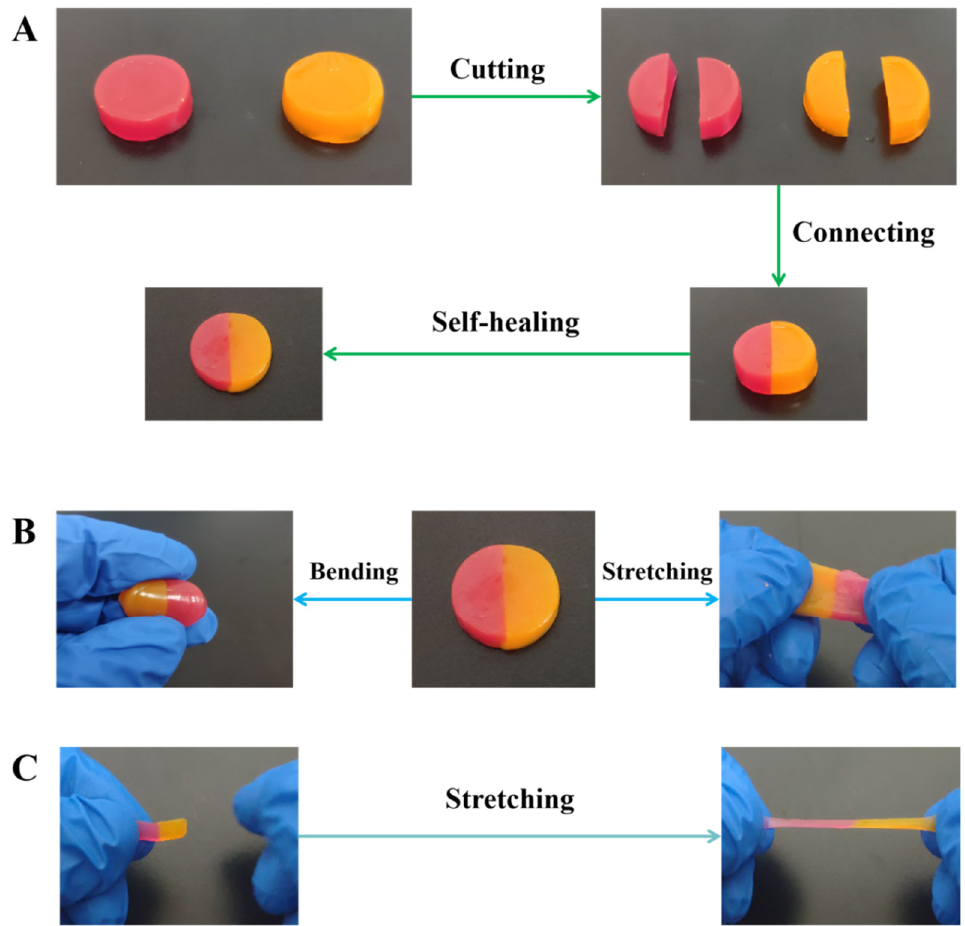
Figure 3. ( A ) Photographs of the self-healing abilities of CMA-3 hydrogel (hydrogel disks colored by rhodamine 6G and rhodamine B). Photographs of CMA-3 hydrogel exhibiting excellent stretching and bending flexibility ( B , C ).